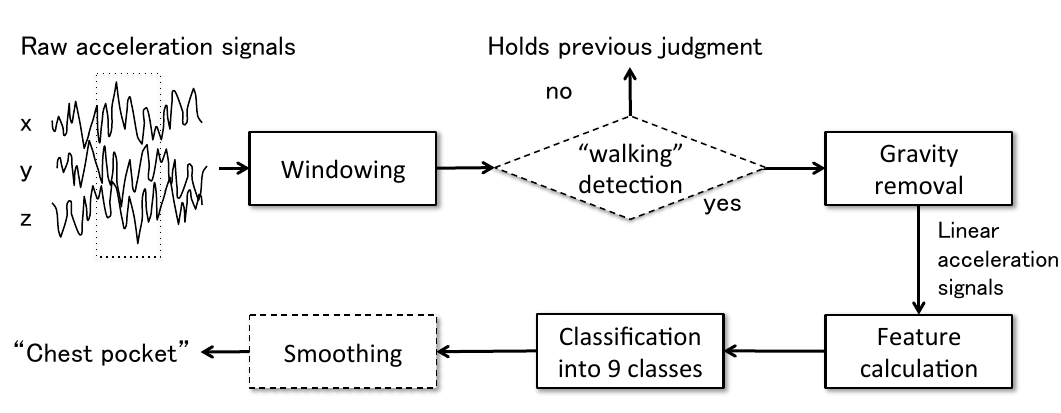
Figure 4. Localization process: the components with a dotted-line have been implemented, but are not the focus of this